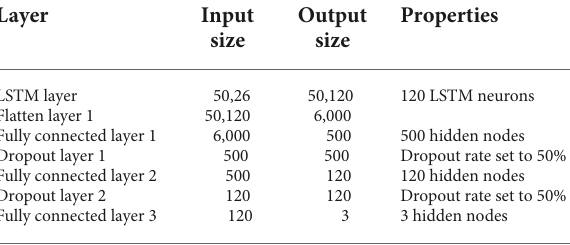
TABLE 2 Input and output shapes of Long Short-Term Memory Neural Network of this study.